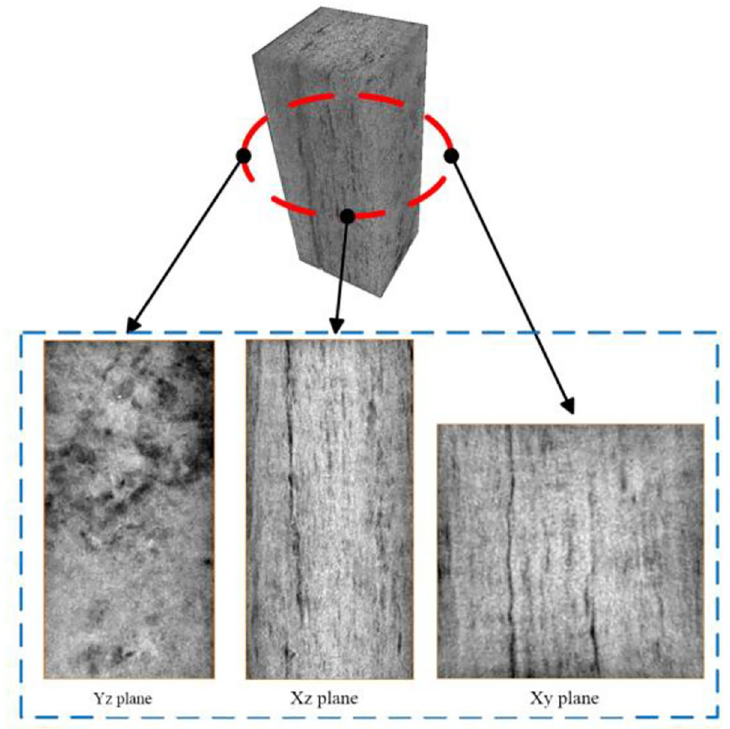
Fig 3. CT scanning of the pore-fracture structure of a coal sample.